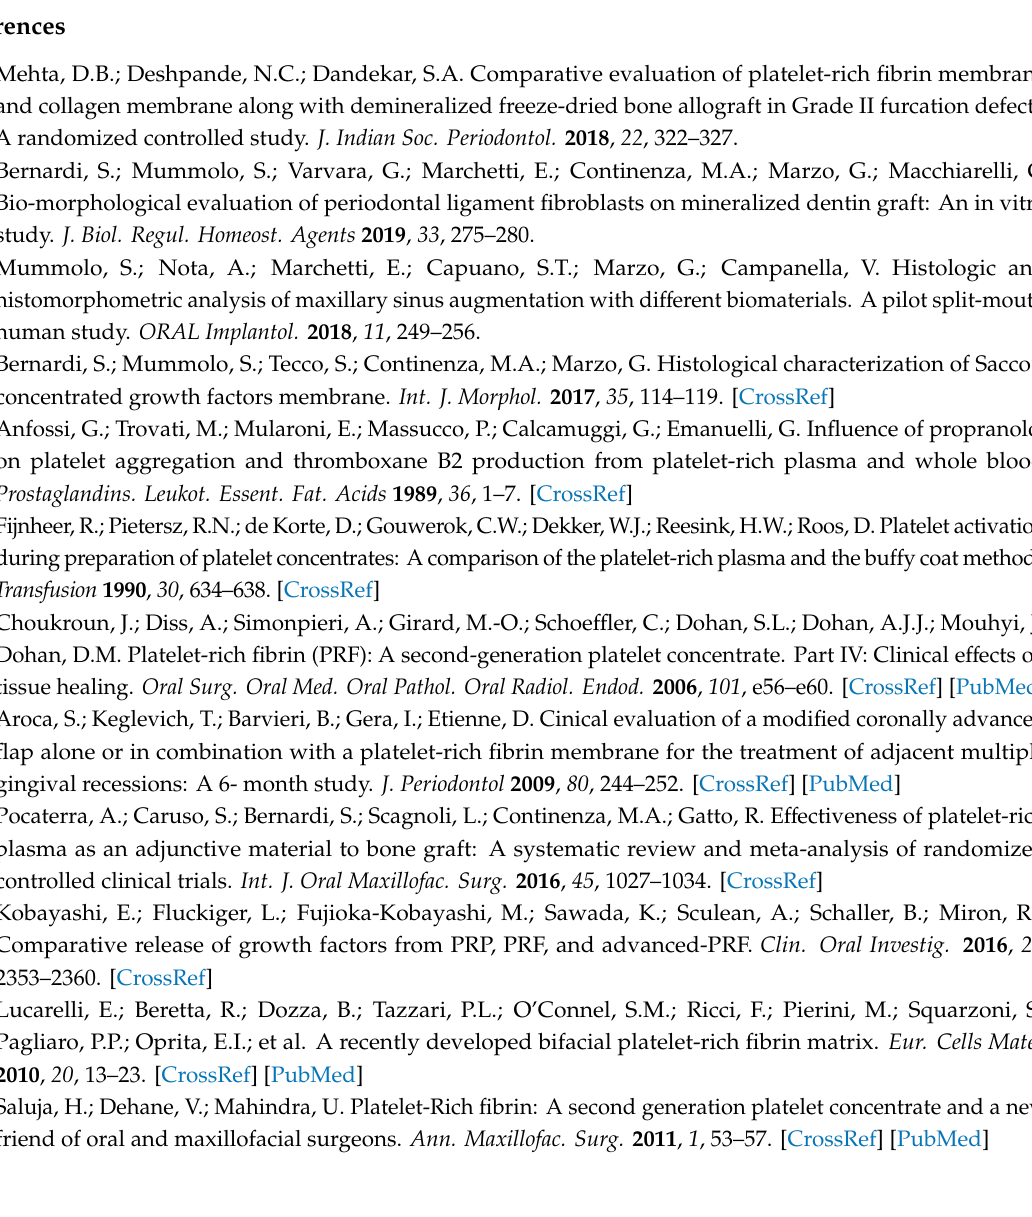
Table S1: The parameter “biomaterials” which compares the proliferation values of the cells cultured with the examined APCs vs the control showed a p value < 0.05, Table S2. Dunnett’s multiple comparison test showed how the means of proliferation of CGF vs CONTROL was statistically significant at 7